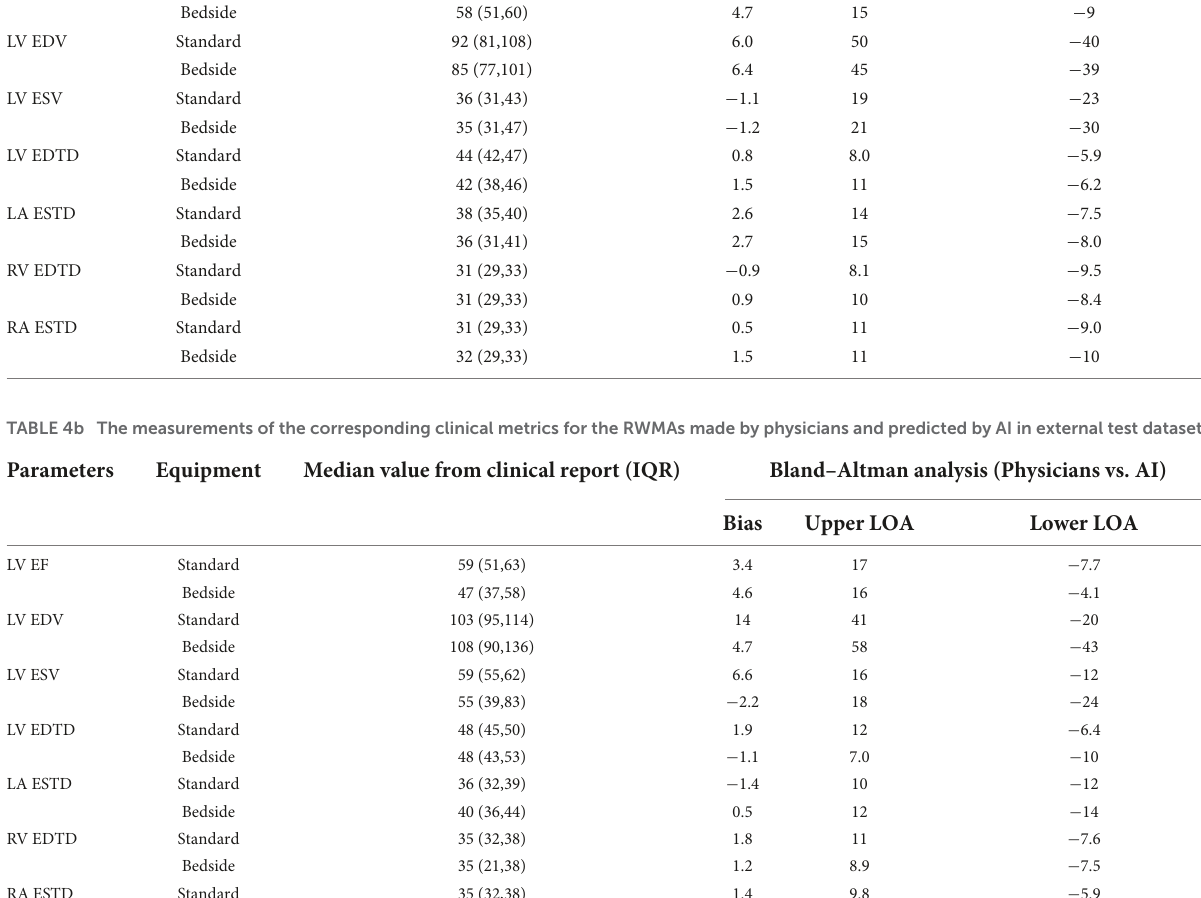
LVEF, left ventricular ejection fraction; LVEDV, left ventricular end-diastolic volume; LVESV, left ventricular end-systolic volume; LV EDTD, left ventricular end-diastolic transversal dimension; LA ESTD, left atrial end-systolic transversal dimension; RV EDTD, right ventricular end-diastolic transversal dimension; RA ESTD, right atrial end-systolic transversal